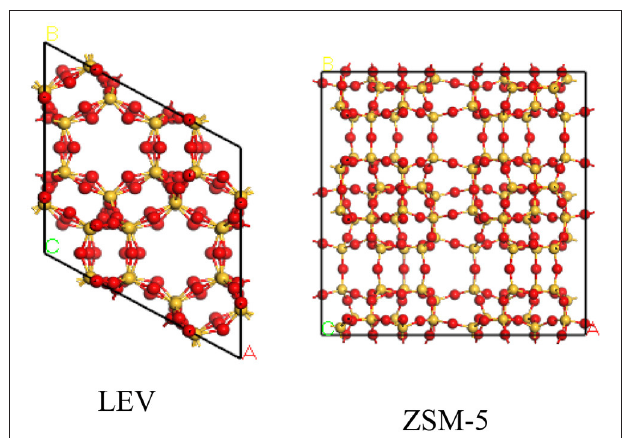
FIGURE 1 | Structures of Lev and ZSM-5. The yellow and red balls denote Si and O atoms,